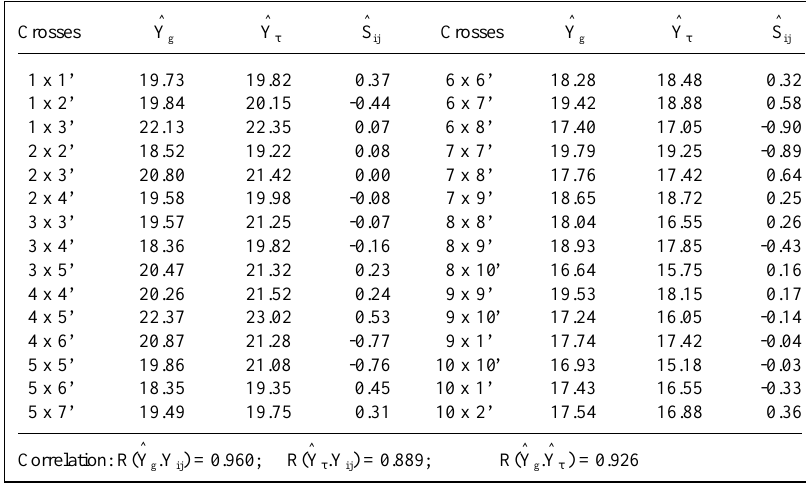
Table X - Estimates of specific combining ability effects (s sampled single crosses based on two models # . Crosses Y g